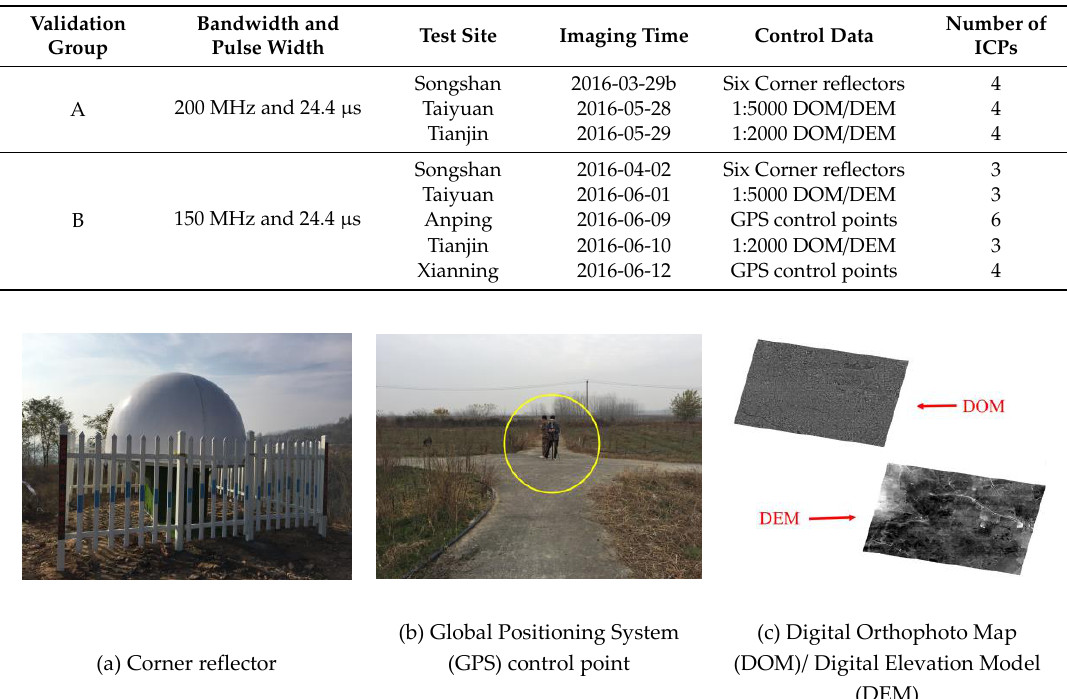
Table 6. Comparison of absolute positioning accuracy of Validation Group A before and after compensating for geometric calibration parameters.